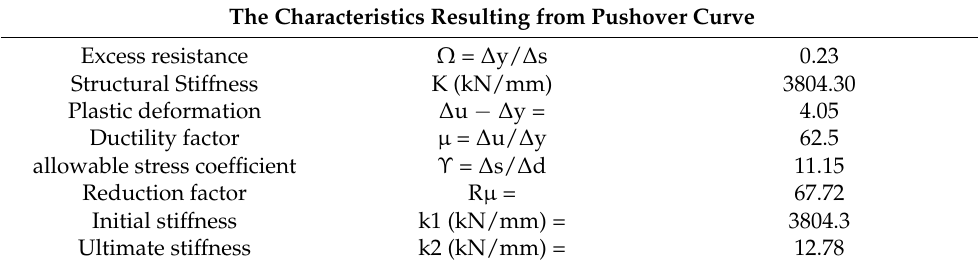
Table 5. The characteristics resulting from pushover curve.